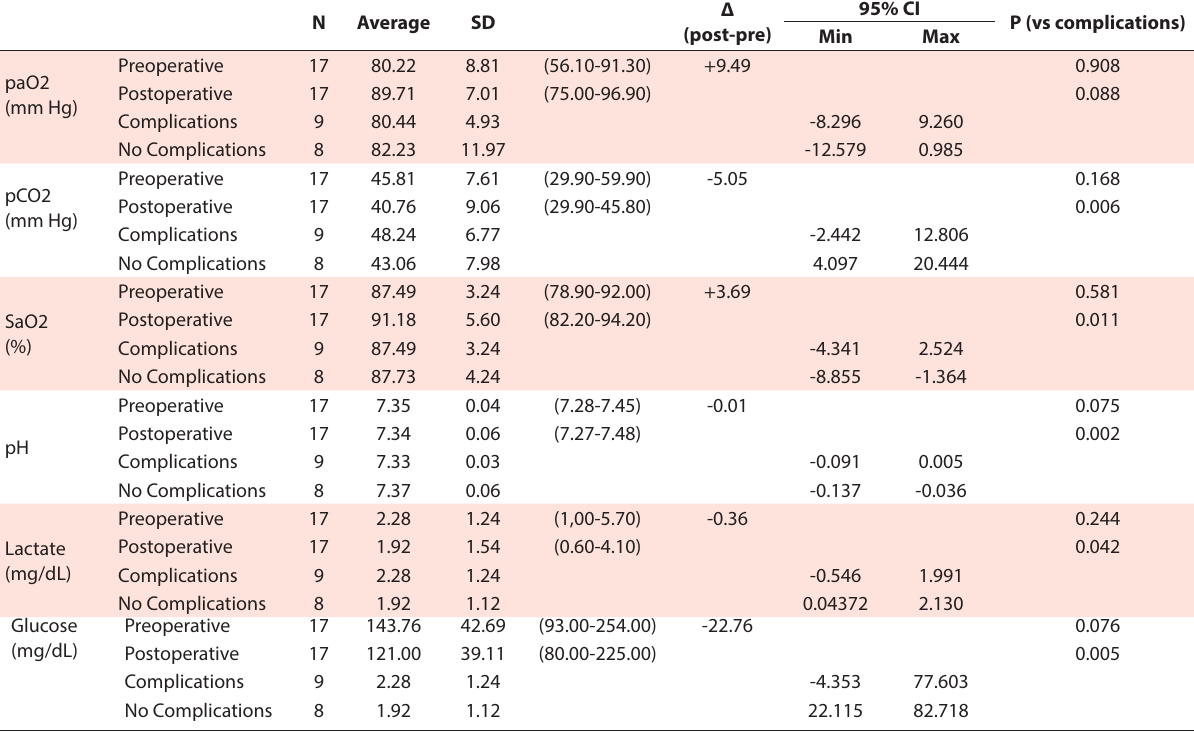
Table 5. Blood gas analysis vs post-operative